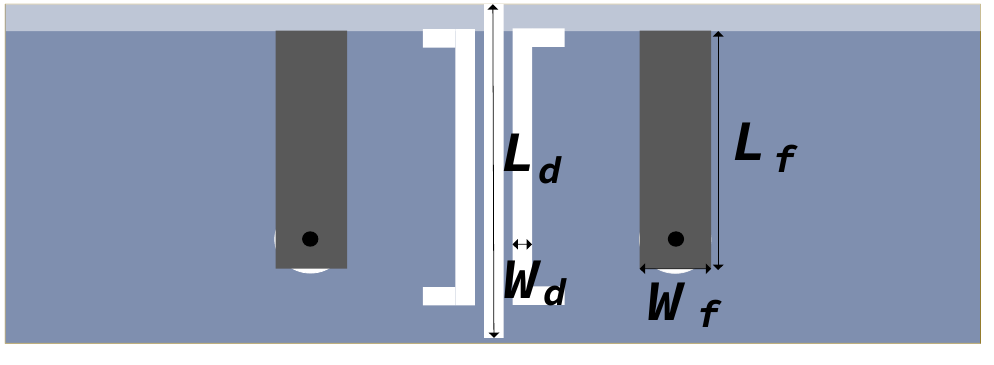
Figure 9. Variable position.